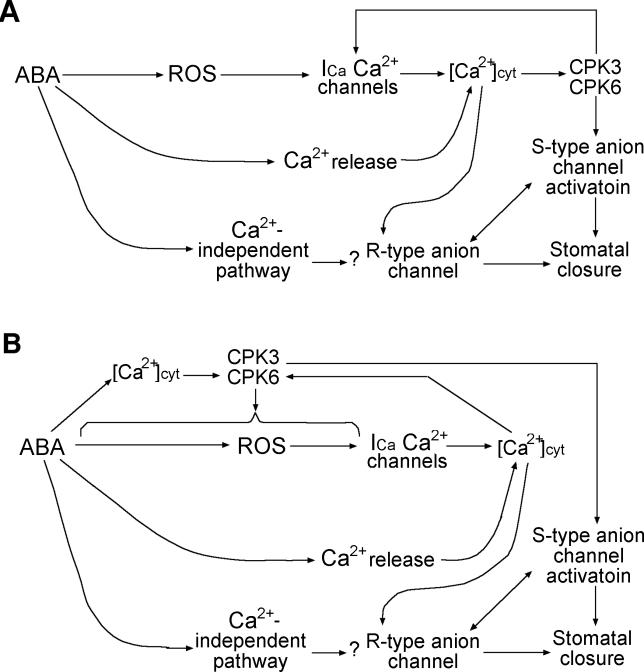
Simplified Models for Early ABA Signal Transduction Network and CPK3 and CPK6 Functions in Guard CellsPlasma membrane ICa channel and intracellular Ca2+-release mechanisms cause cytosolic Ca2+ elevations. CPK3 and CPK6 mediate [Ca2+]cyt activation of S-type anion channels. CPK3 and CPK6 regulate ICa Ca2+ channels by a proposed feedback (A) or parallel pathway (B) or by transcriptional/translational regulation mechanism (see Discussion). R-type anion channels are regulated in a parallel CPK3-CPK6-independent signal transduction pathway. The arrow connecting R-type and S-type anion channels indicates that these channels may share molecular components [89]. See Discussion for details.